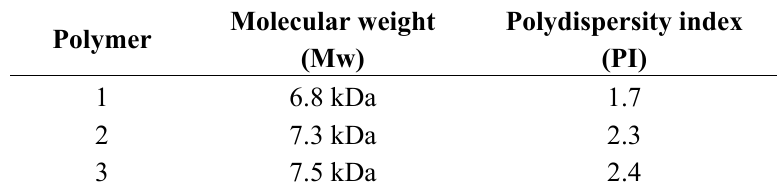
Table 1. Molecular weights and polidispersity indexes of synthesized